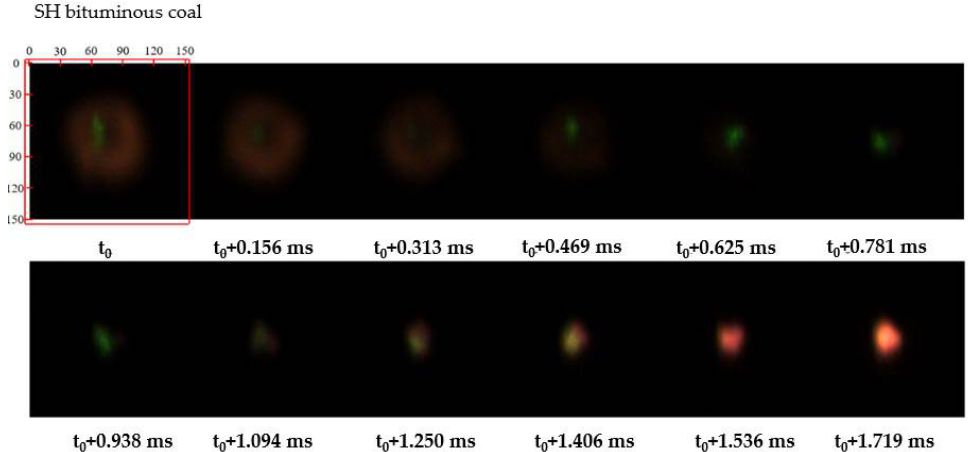
Figure 4. Continuous images of pulverized coal particles from the volatile burning stage to the char combustion stage.